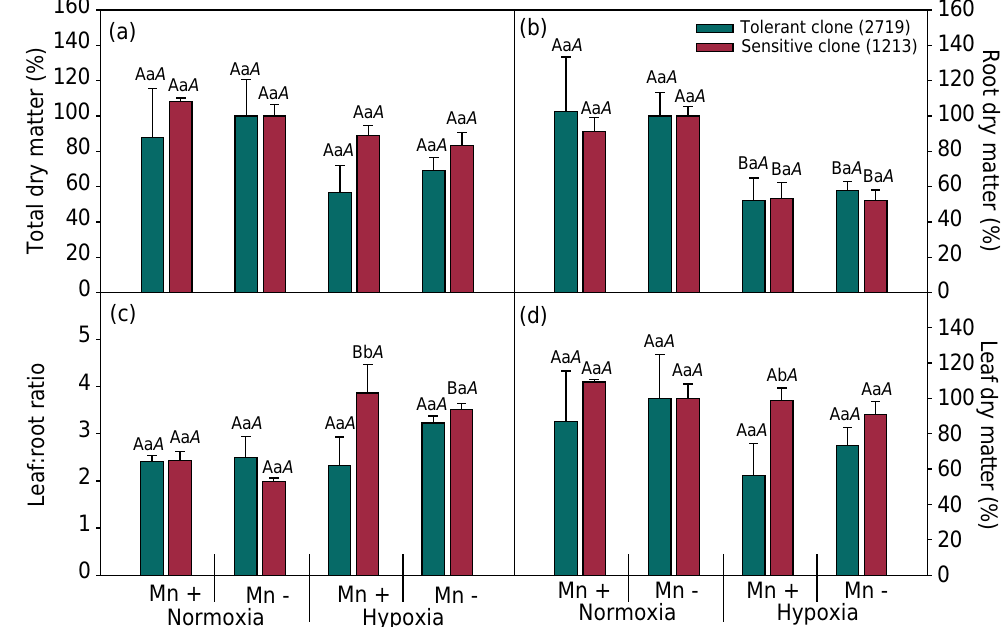
Figure 1. Dry matter production of the hydroponic experiment using two Eucalyptus clones. Total dry matter from the control treatment (a). Root dry matter from the control treatment (b). Relationship between leaf dry matter and root dry matter (c). Leaf dry matter relative to the control treatment (d). Uppercase letters compare the effect of O 2 (normoxia: 8 mg L -1 ; and hypoxia: 4 mg L -1 ) for the same clone and the same Mn concentration. Lowercase letters compare the effect of clones (tolerant and sensitive to VRDSD) for the same concentrations of Mn and O 2 . Uppercase italic letters compare the effect of the Mn concentration of the nutrient solution (300 and 1.39 mg L -1 ) for the same clone and the same O 2 concentration. Equal letters do not differ statistically at the level of 5